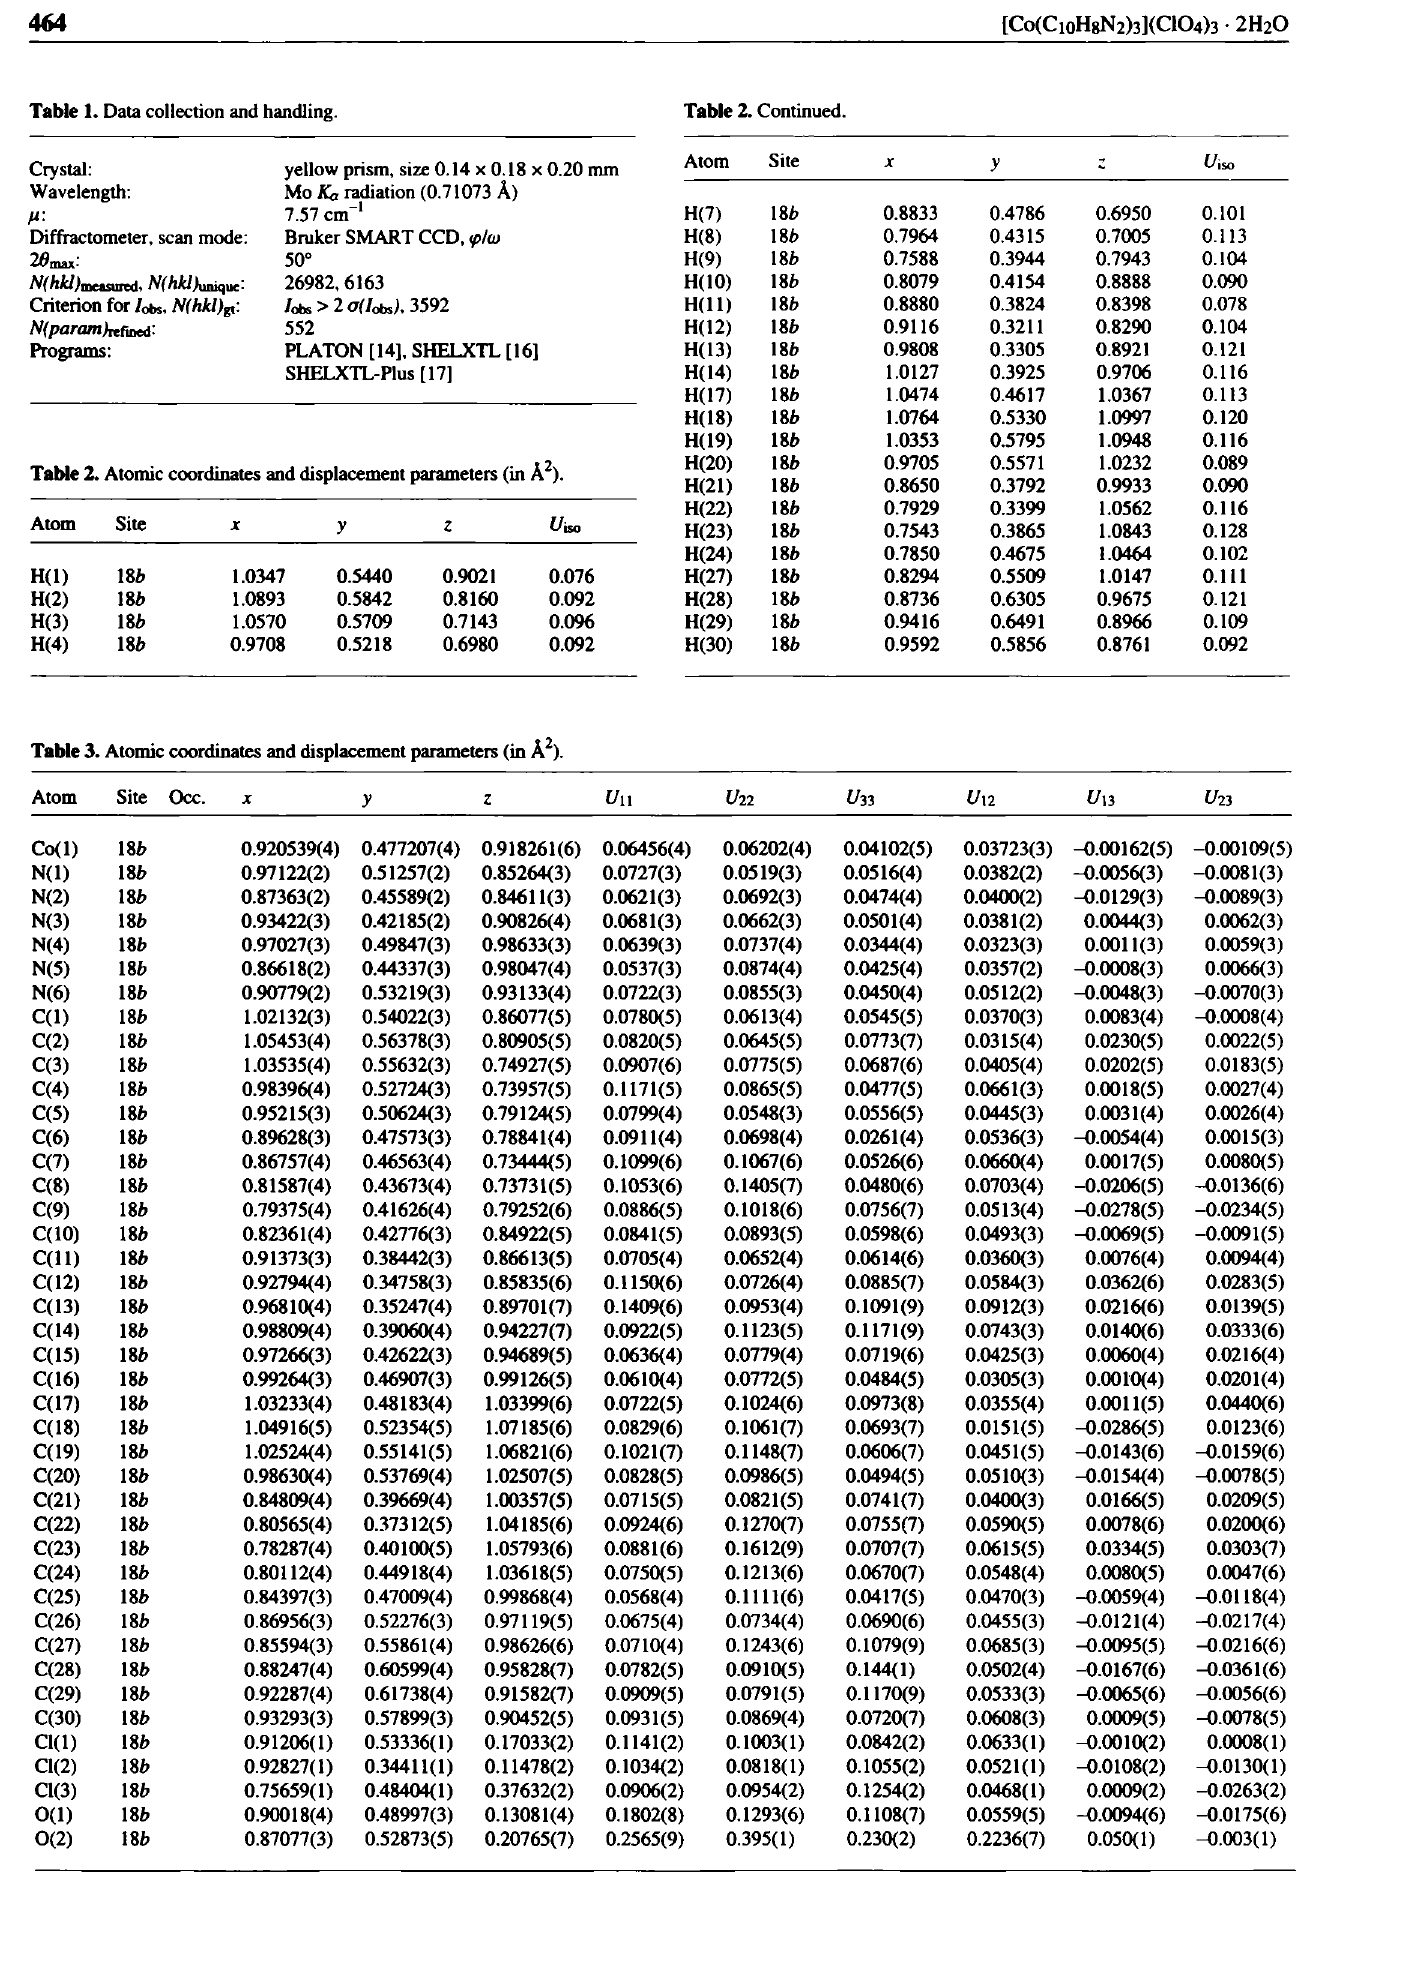
Table 2. Atomic coordinates and displacement parameters (in A 2 ).